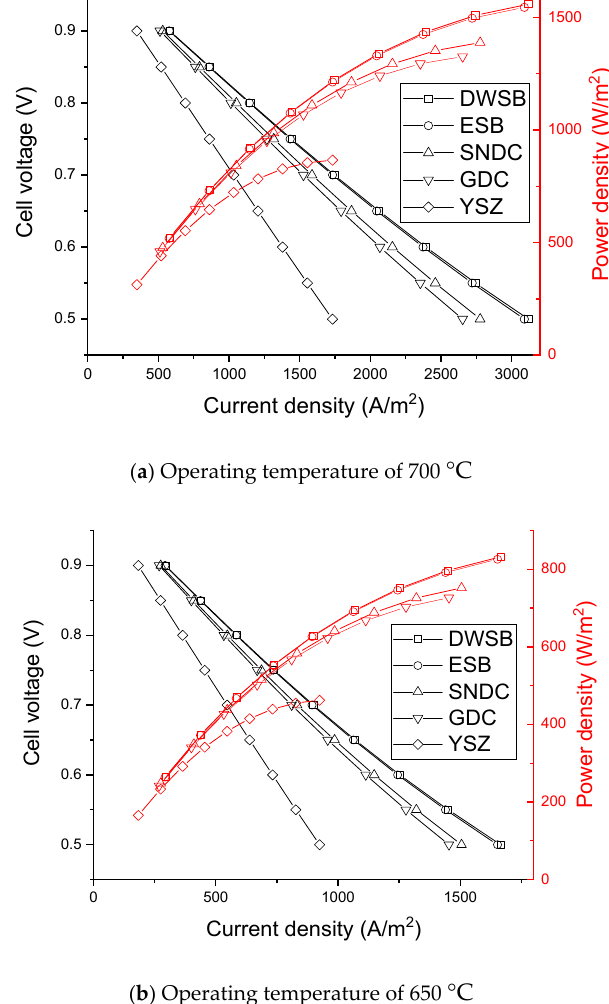
Energies 2020 , 13 , x FOR PEER REVIEW Figure 4. Performance of SOFC with different electrolytes at two operating temperatures. Figure 4. Performance of SOFC with di ff erent electrolytes at two operating temperatures.